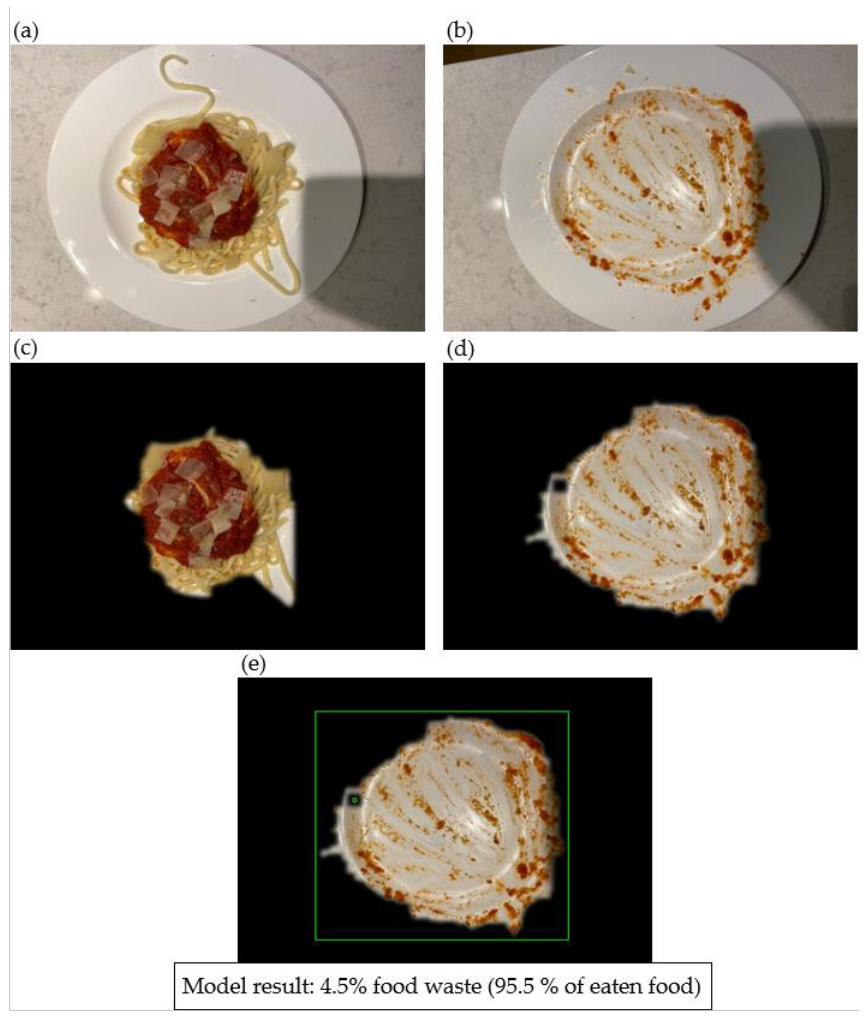
Figure 4. The example of images ( a ) before the meal, ( b ) after the meal, ( c ) before the meal and masked and ( d ) after the meal and masked.